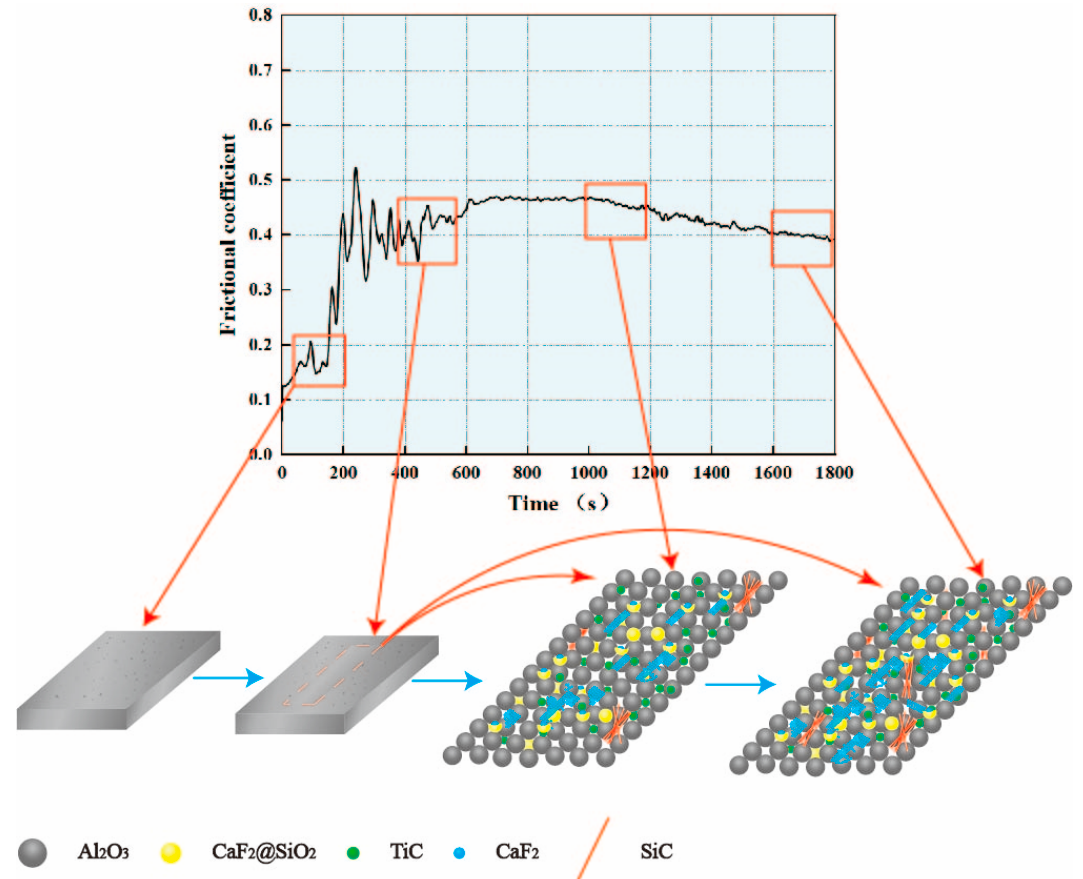
Figure 2. Friction coefficient over time.